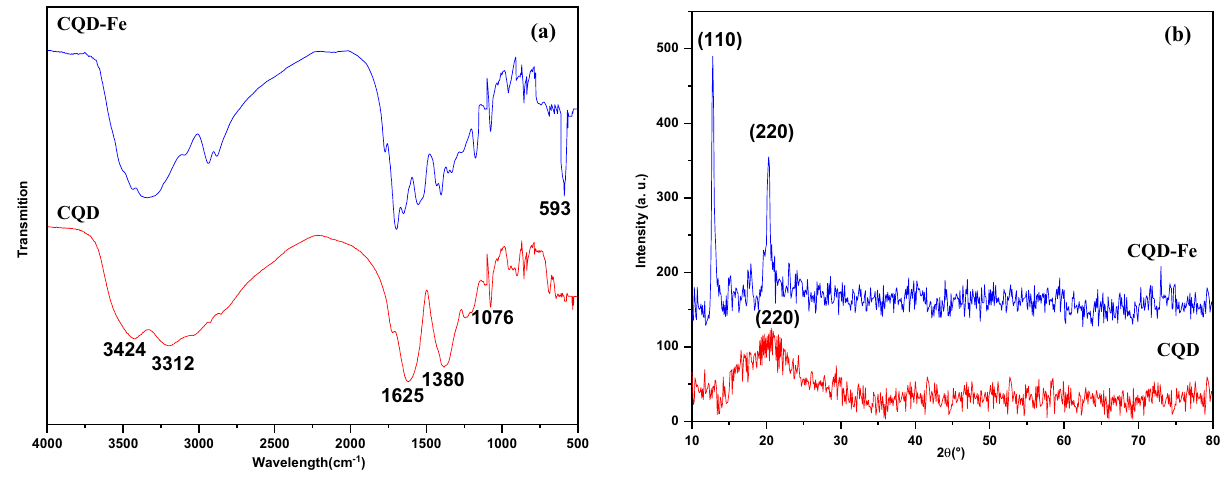
Figure 4. FT-IR spectrum ( a ) and XRD pattern ( b ) of the CQD and CQD-Fe